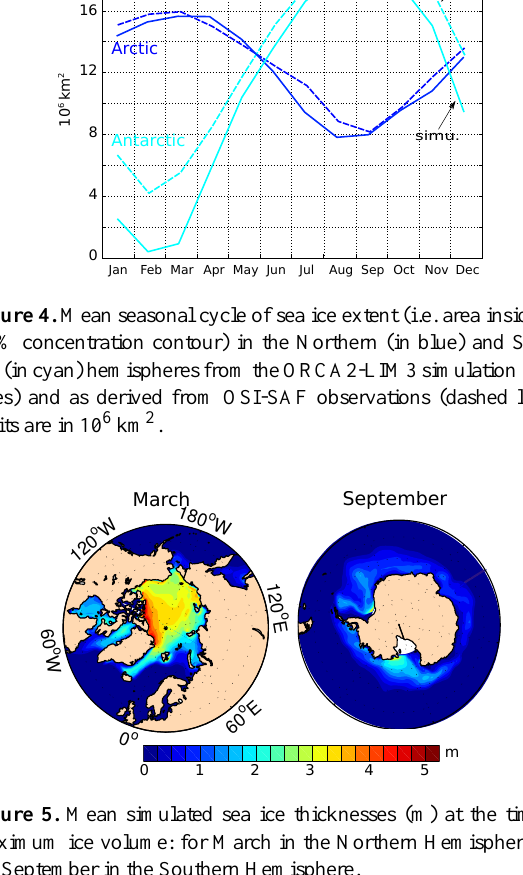
Figure 3. Mean sea ice concentrations from the simulation ORCA2- LIM3 and the observations OSI-SAF for March and September in the Arctic (left panels) and February and September in the Antarc- tic (right panels). The white line indicates the 15% ice concentra- tion contour.